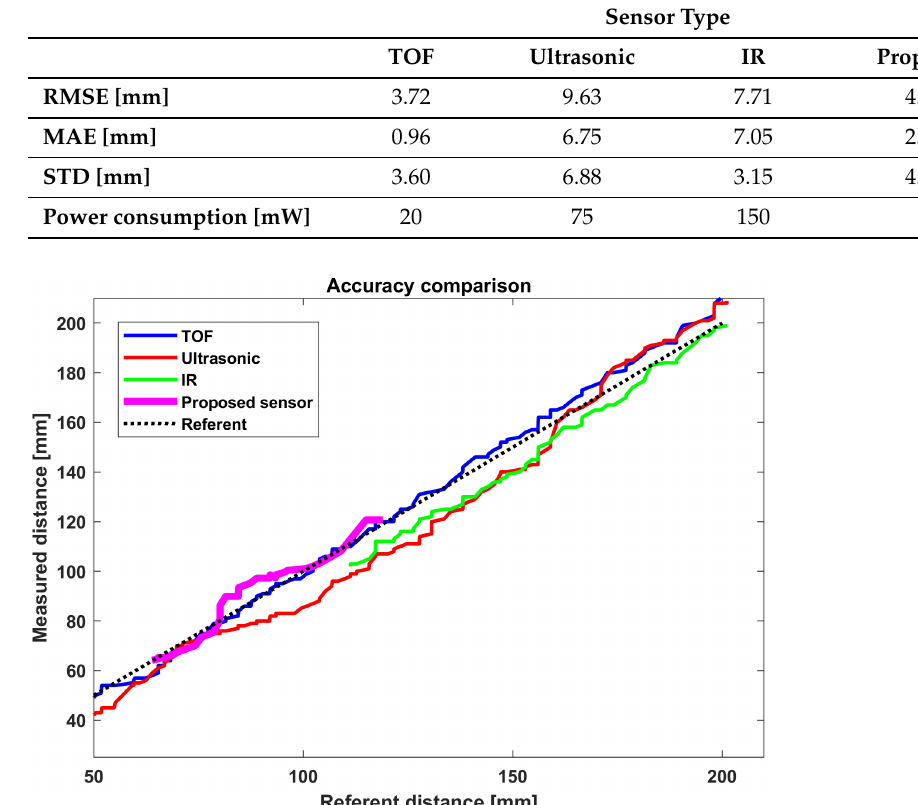
Figure 8. Accuracy comparison for several sensors used in sensor subsystem.